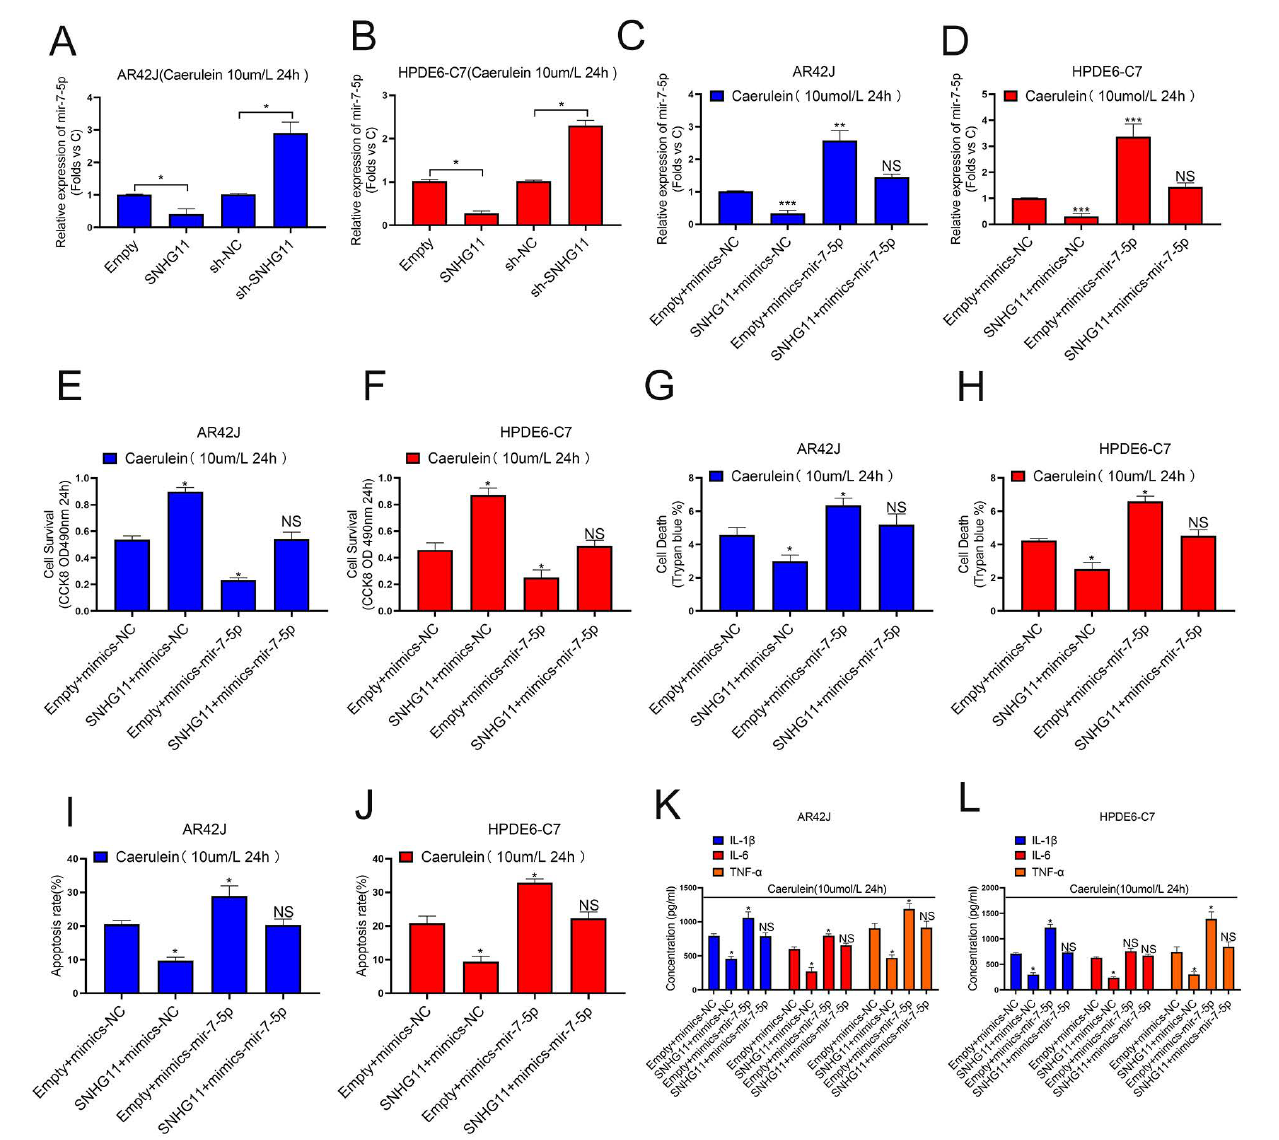
Figure 4. LncRNA-SNHG11 plays a role in pancreatitis through MiR-7-5p. ( A , B ) The regulation effect of SNHG11 expression on MiR-7-5p was observed in AR42J and HPDE6-C7 cells. ( C , D ) The expression of miR-7-5p in different pancreatitis cell models was verified. ( E , F ) Cell proliferation was assessed by CCK8 assay in AR42J and Hpde6-C7 Cell models. ( G – J ) The effects of SNHG11 on cell death and apoptosis in AR42J and HPDE6-C7 cell models were observed by Trypan blue assay and Flow cytometry assay. ( K , L ) Expression of IL-6, TNF- α , and IL-1 β in the AR42J and HPDE6-C7 cell lines assessed by ELISA. The data are presented as means ± SDs, n = 3 for each group, * p < 0.05; ** p < 0.01; *** p < 0.001, NS = no significance, between the indicated